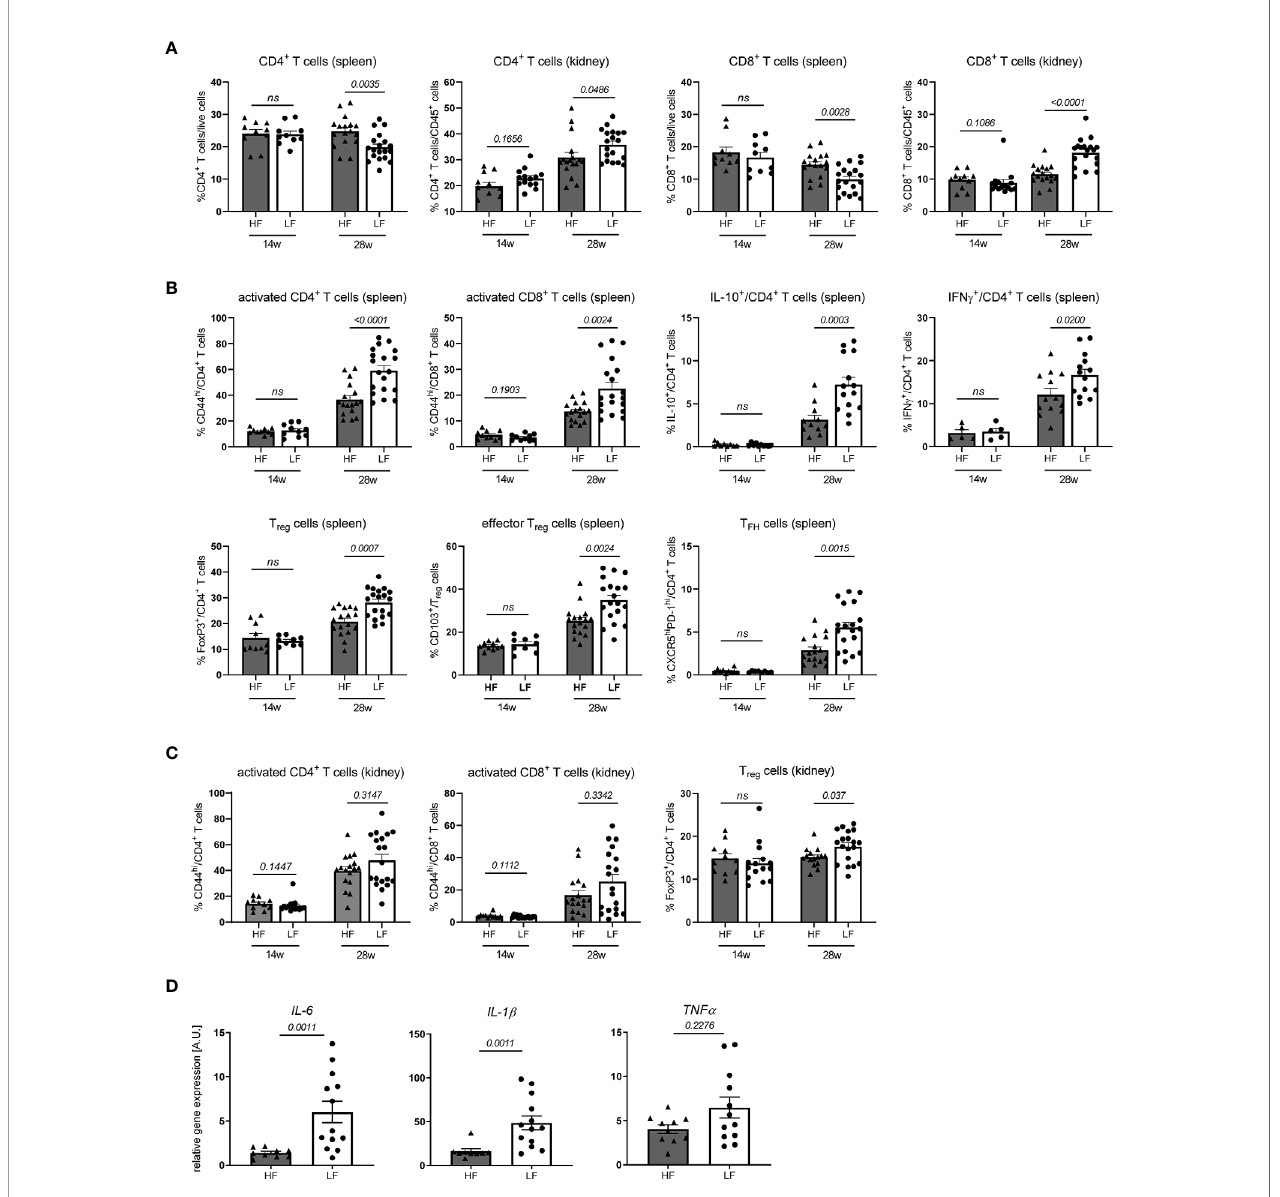
FIGURE 2 | HF-treated mice display a less in fl amed immune status. (A – C) Broad immune status evaluation in HF- and LF-treated NZB/WF1 mice by FACS in 14 w (n HF/LF = 10 – 15 mice) and 28 w old animals (n HF = 11 – 17 mice, n LF = 14 – 19 mice). (A) Relative proportions of CD4 + and CD8 + T cells in spleen and kidney. (B, C) Most prominent differences in immune cell differentiation between HF- and LF-treated mice: CD44 hi expression on CD4 + and CD8 + as marker of T cell activation, expression of IL-10 or IFN g on CD4 + T cells, frequencies of FoxP3 + T reg , CD103 + FoxP3 + effector T reg and CXCR5 hi PD-1 hi T FH cells. (D) Relative mRNA expression of IL-6, IL-1 b and TNF a was examined in kidneys of 28 w old animals (n HF = 9 – 10 mice, n LF = 12 – 13 mice). Results are expressed as scatter blots with mean ± SEM; each data point represents an individual mouse; p < 0.05 was considered signi fi cant, p > 0.2 is indicated as ns, not signi fi cant